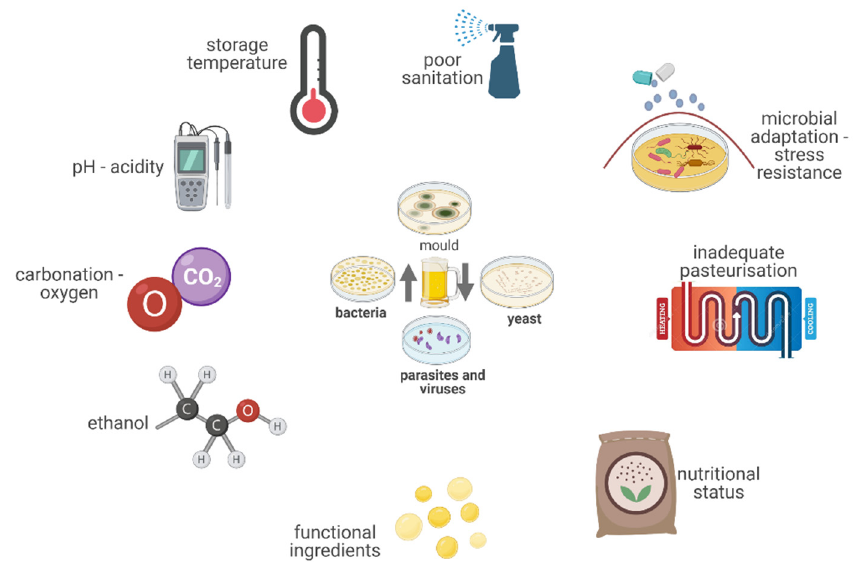
Figure 2. Microbial spoilage of beer. Table 2. Different types of beer spoilage by different